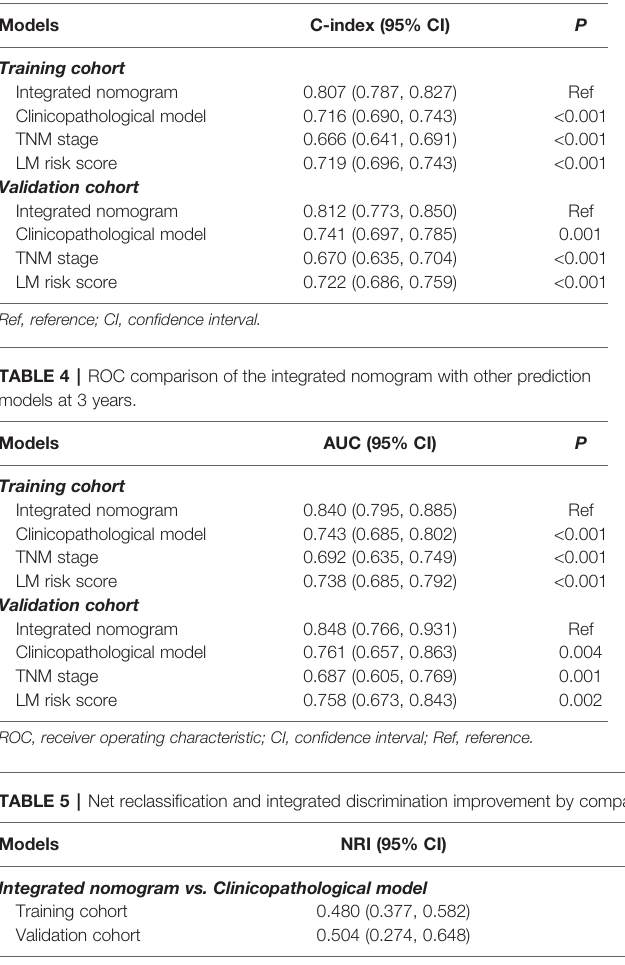
TABLE 3 | C-index comparison of the integrated nomogram with other prediction models.